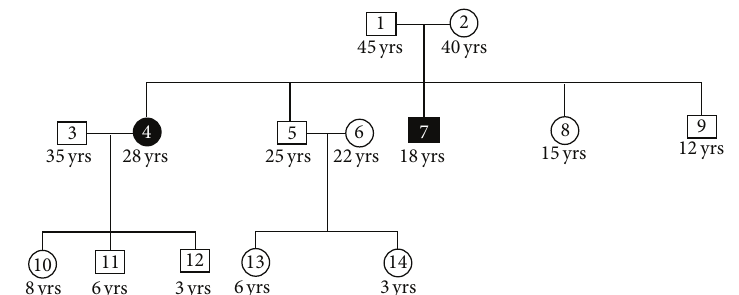
Figure 3: Pedigree of patient’s family.